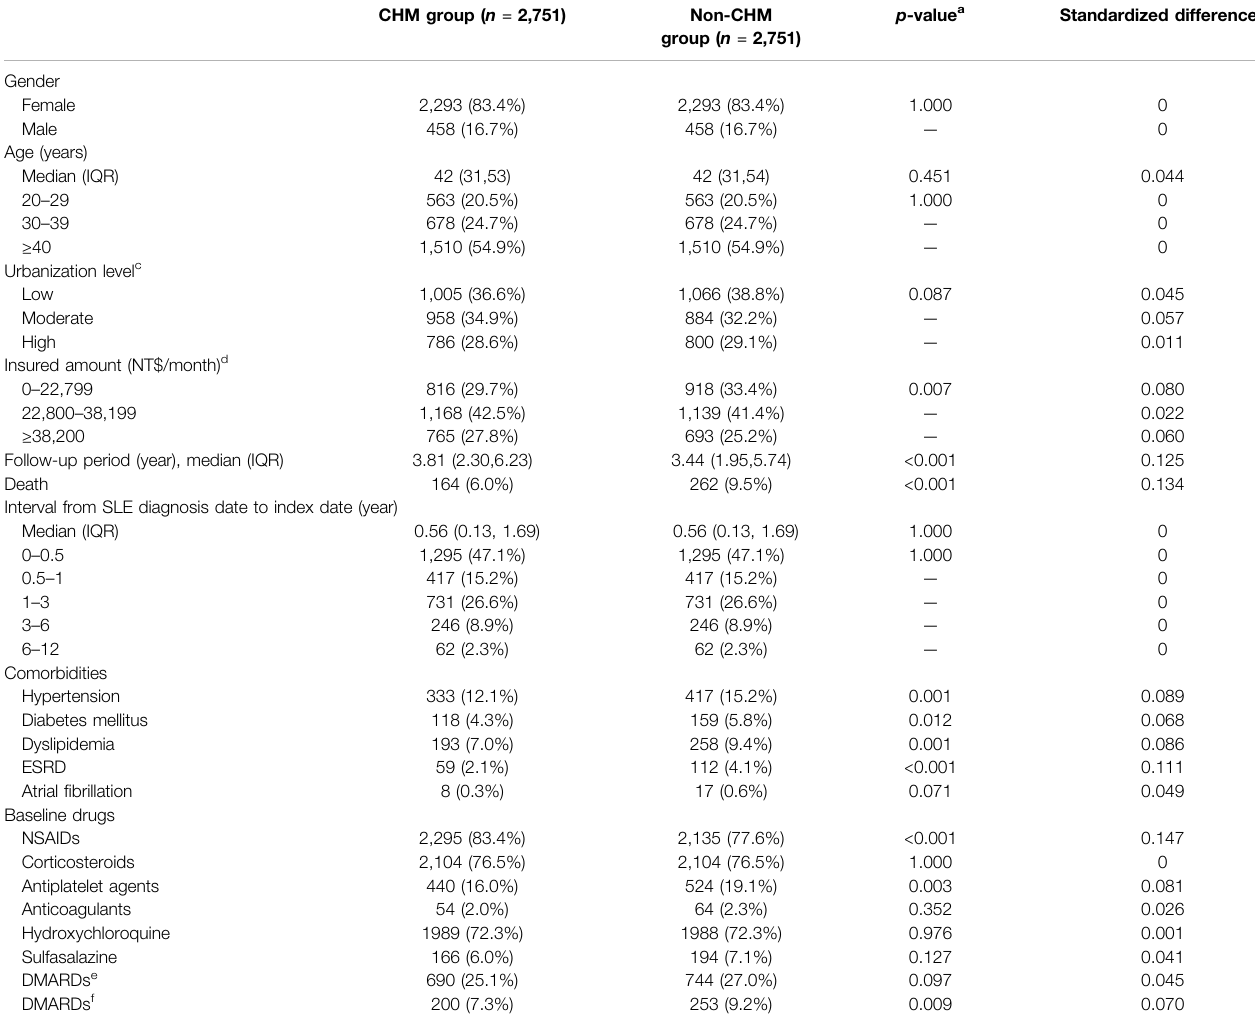
TABLE 1 | Characteristics of systemic lupus erythematosus patients treated with and without Chinese herbal medicines. CHM group ( n =